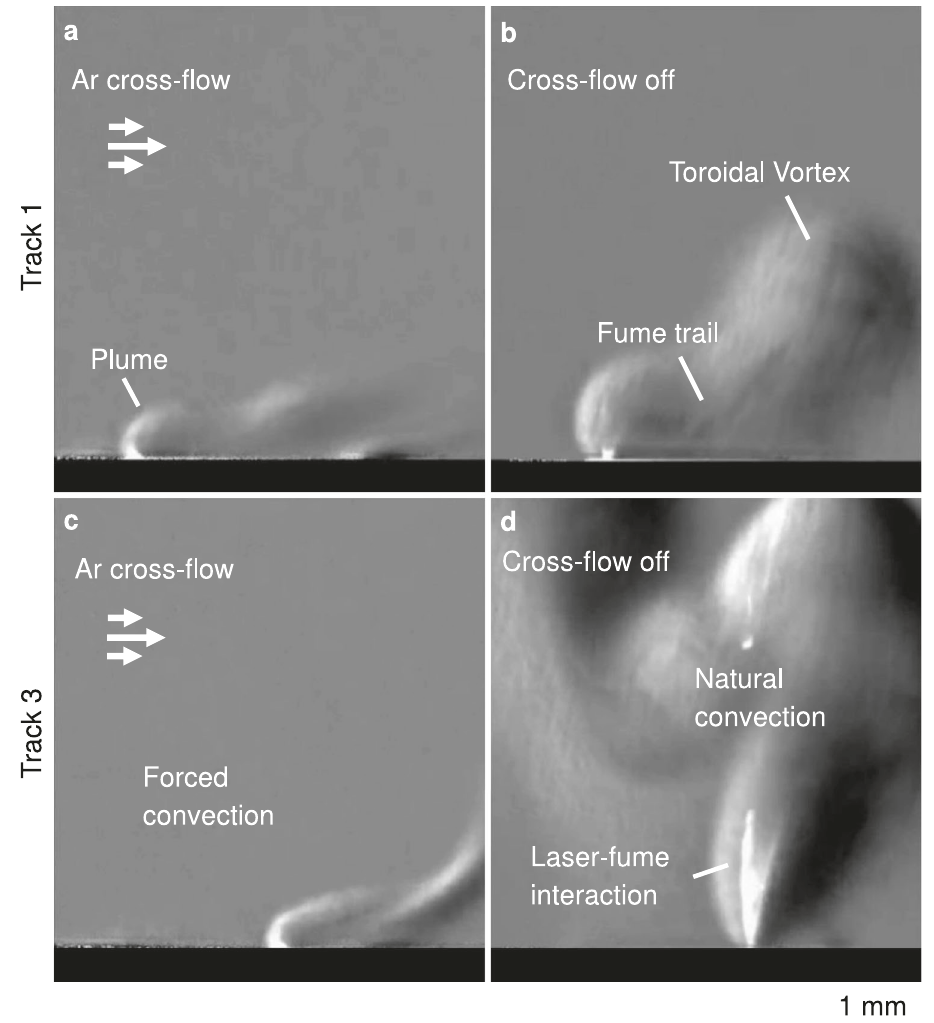
Fig. 7 Schlieren images of the Ar atmosphere above SS316 samples during 5 × 5 mm 2 island scans, with and without cross- fl ow (peak Re ~ 1400, − 1 ). In all images, the laser is moving right to left, v = 0.75 m s − 1 . Refractive index gradients outline the plume above the melt pool regardless u max ~ 2.1 m s of the cross- fl ow, due to the strong evaporation from the depression. a , b Track 1 of the scan: the laser-material interaction is similar in both cases, as the laser processes through a clear atmosphere. c , d Track 3 of the scan: c By-products from earlier tracks are extracted with the cross- fl ow on, promoting repeatability. d Frequent laser-fume interactions were observed when processing in a fume-rich